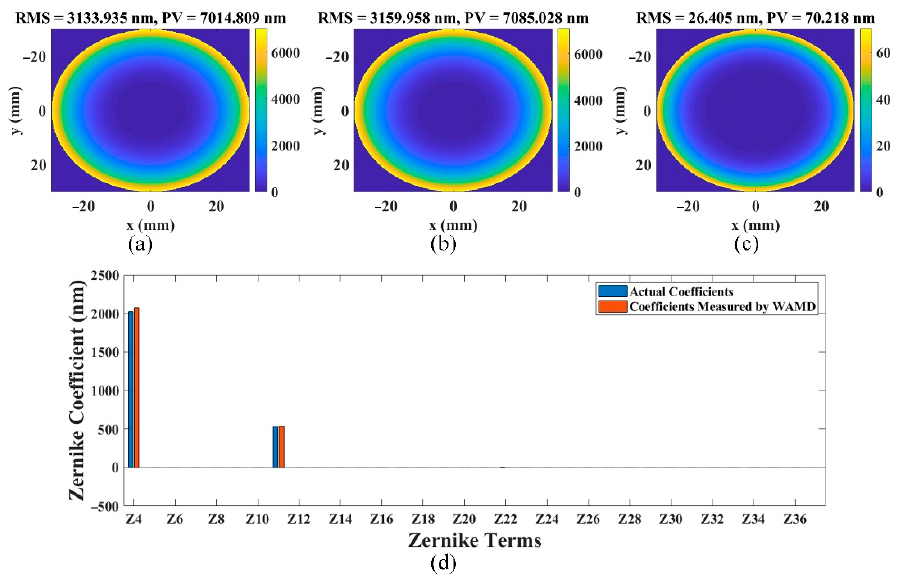
Figure 3. Wavefront aberration of the plano-convex lens in the simulation: ( a ) actual wavefront aberration; ( b ) wavefront aberration measured by WAMD; ( c ) difference between ( a , b ); ( d ) comparison of Zernike coefficients.